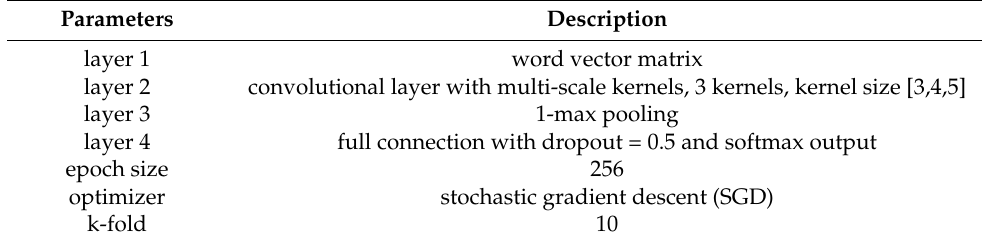
Table 7. The CNN model parameters